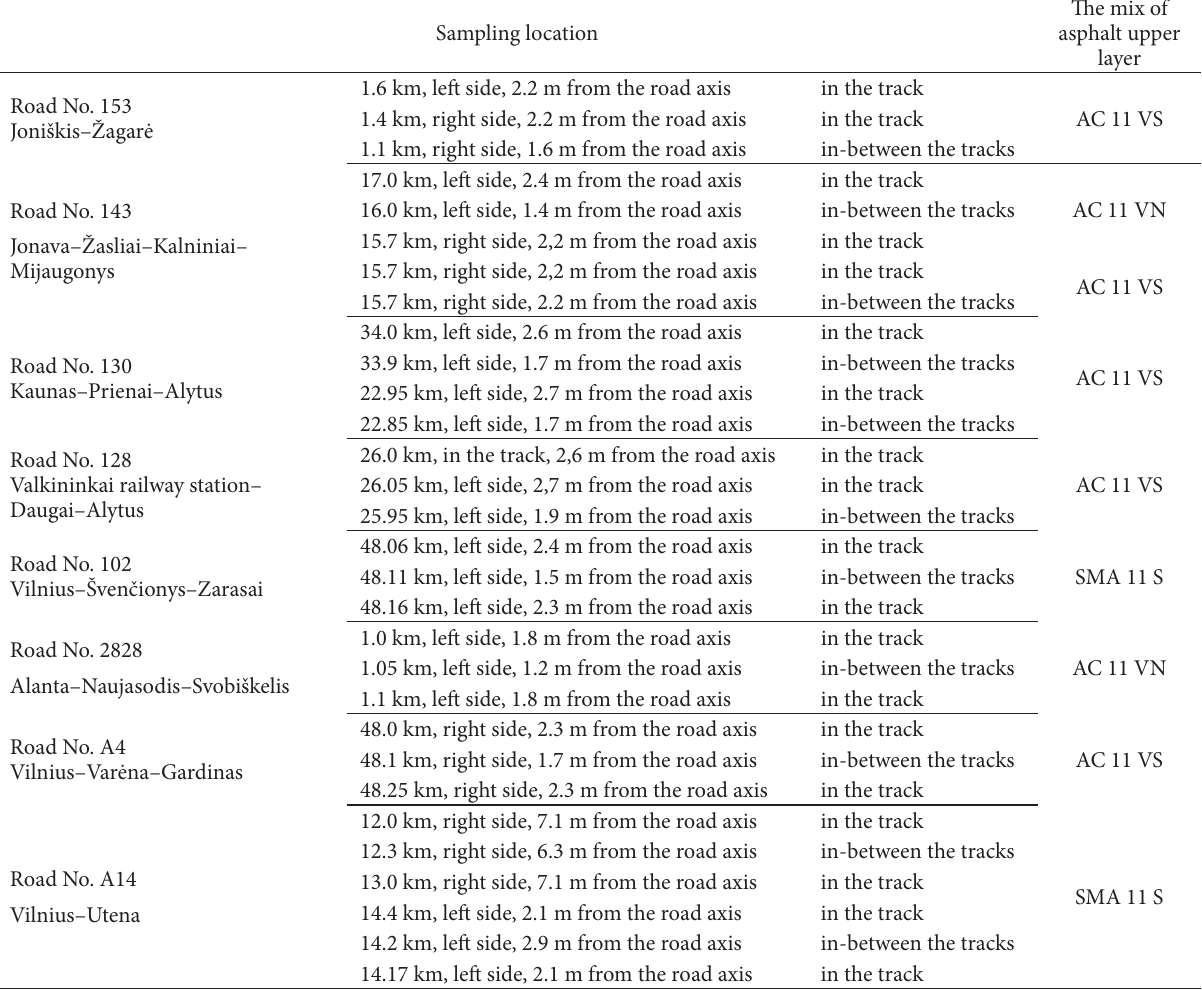
Table 3. Sampling locations